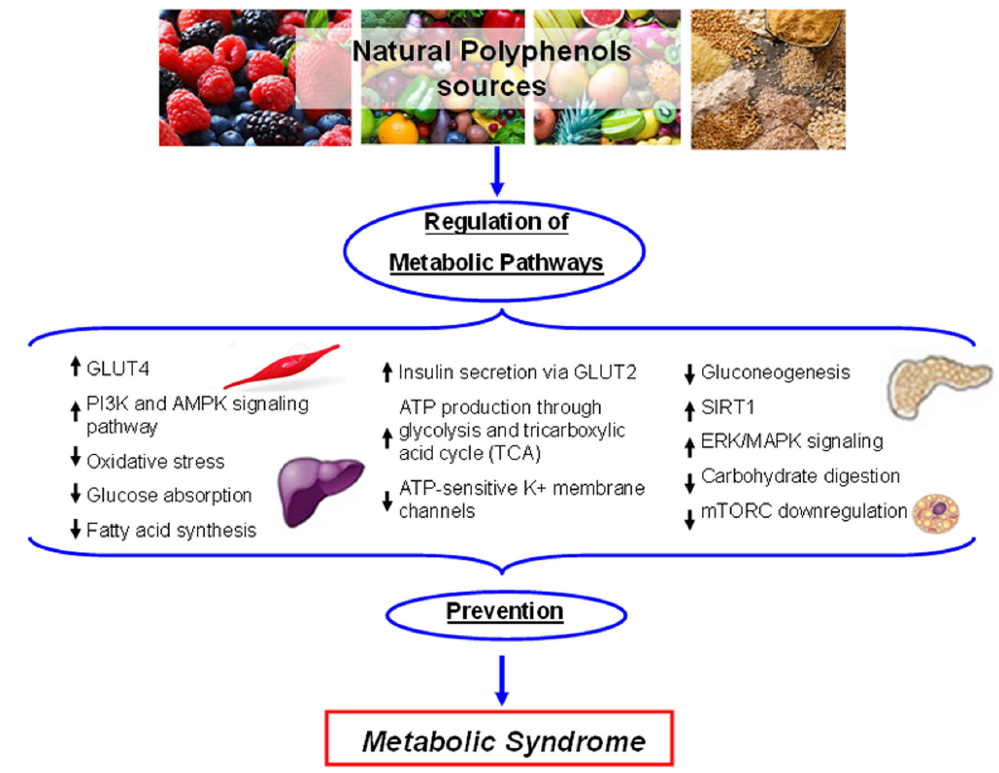
Figure 4. Schematic representation of the main metabolic pathways influenced by plant Activated pathways: ↑ ; Inactivated pathways: ↓ polyphenols. Activated pathways: ; Inactivated pathways: .